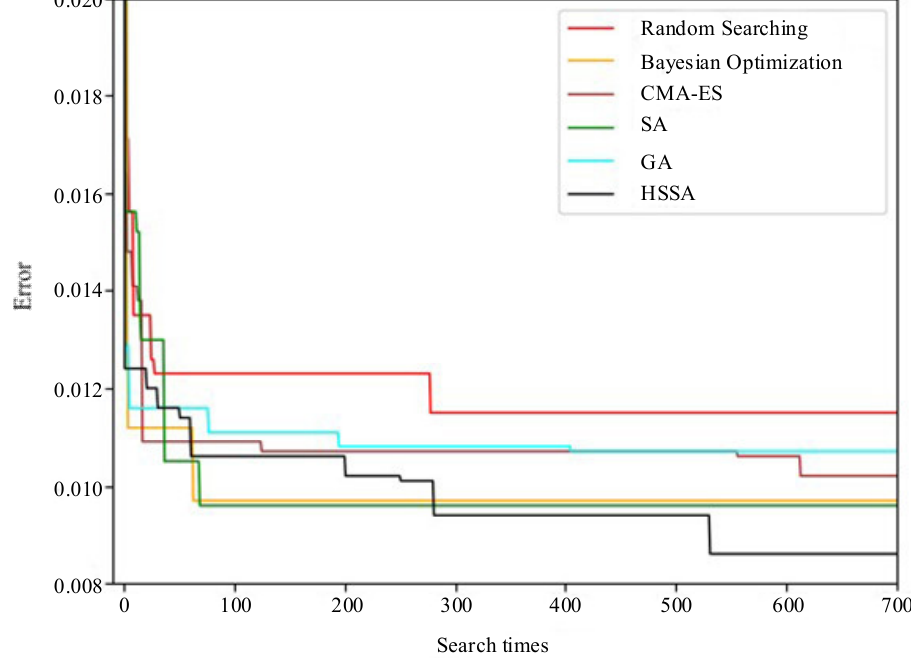
Figure 5. Result of the performance verification experiment on MNIST.